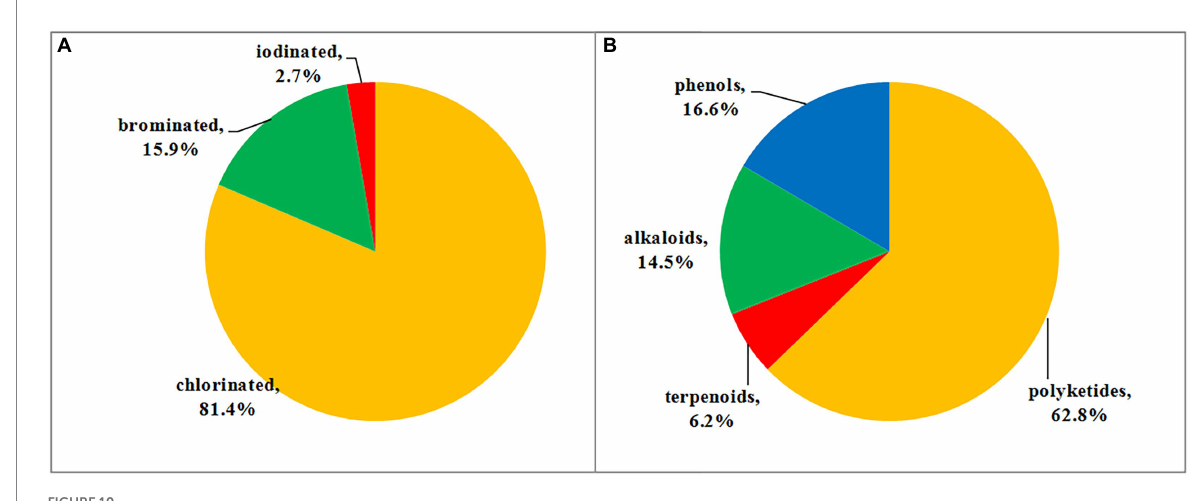
FIGURE 10 (A) Proportion of halometabolites from marine-derived fungi; (B) Structural classes of